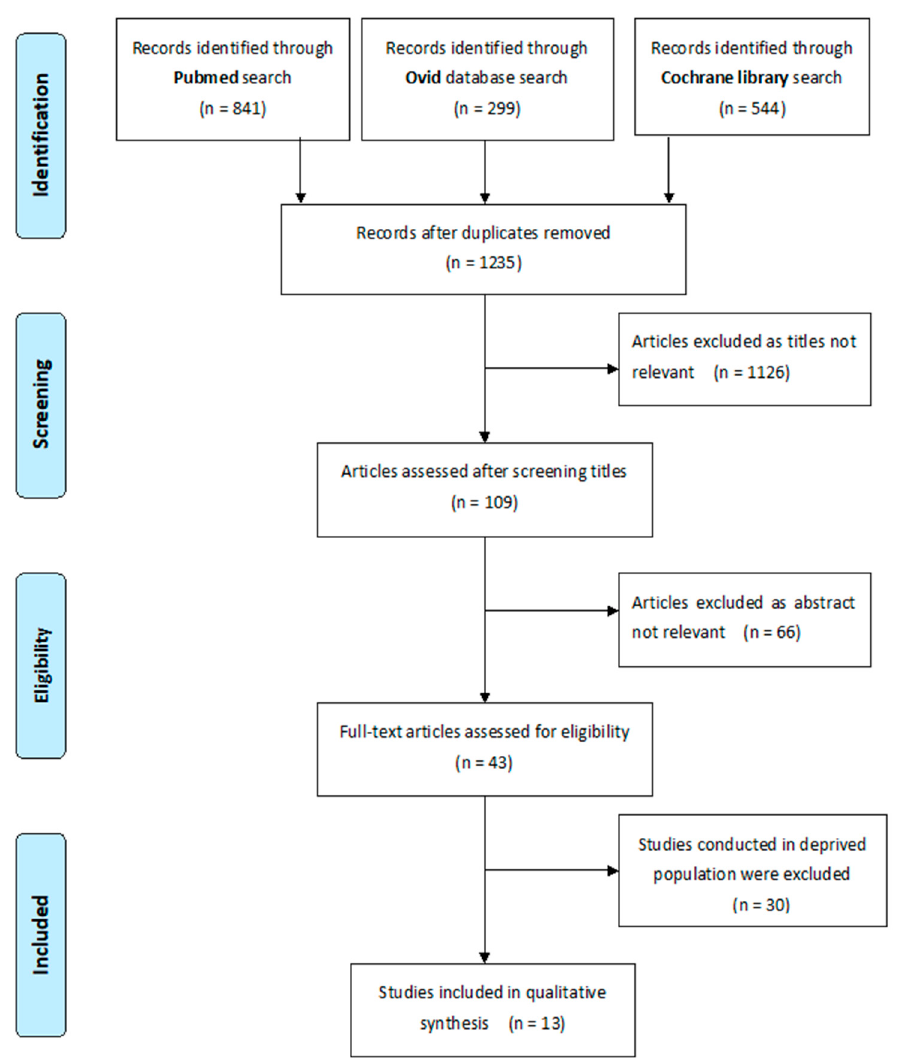
Figure 1. Flowchart of the selection of studies for the systematic